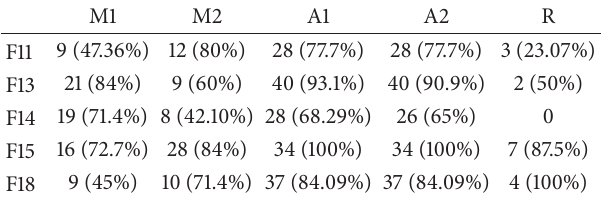
Table 2: Storage conditions for each of the five trials. Trial